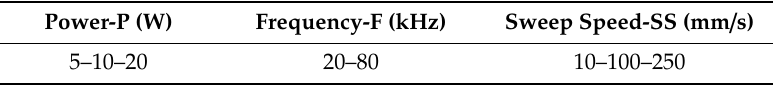
Table 3. Experimental design for laser